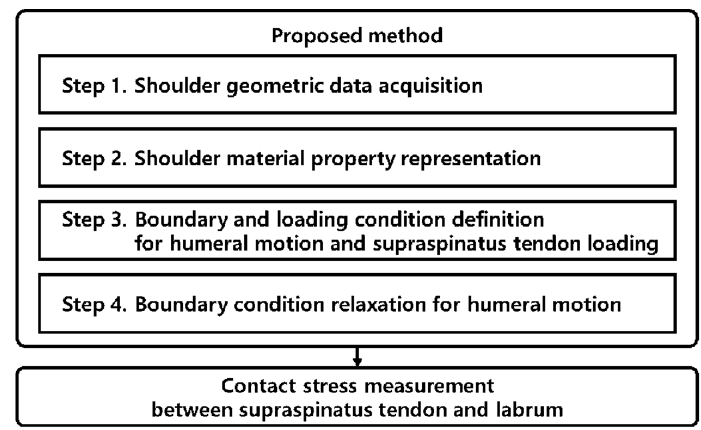
Figure 1. Block diagram of the proposed method.